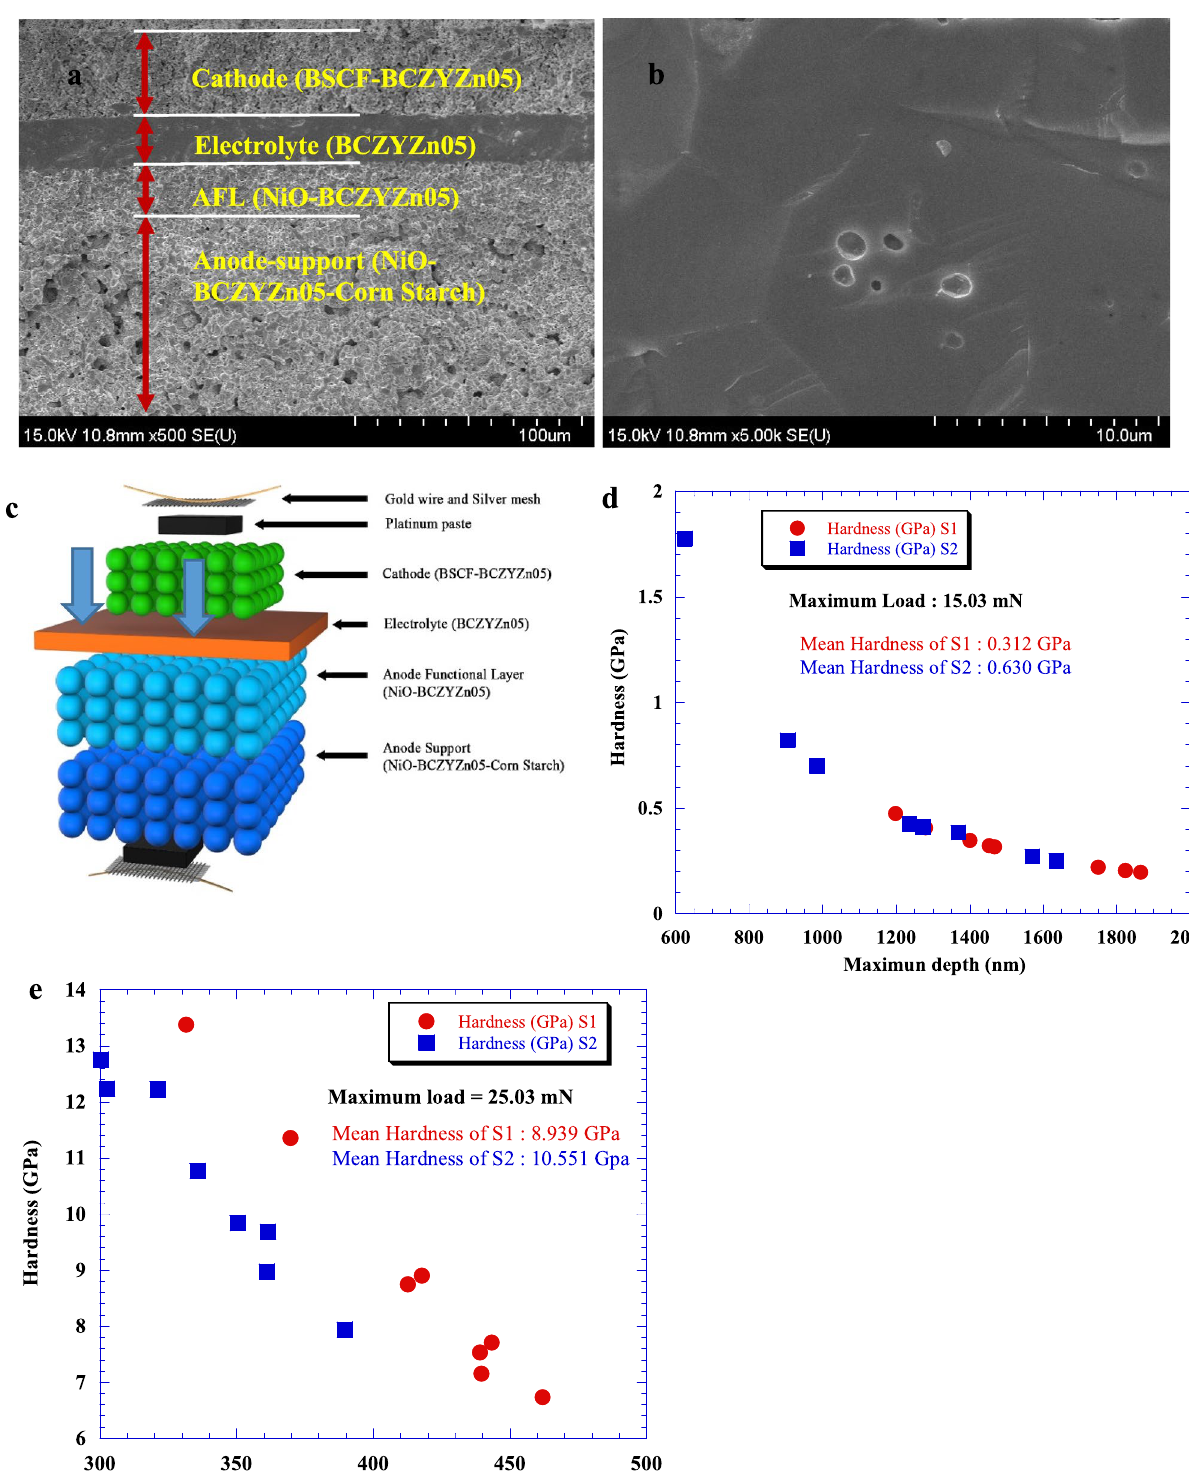
Figure 2. SEM analysis and hardness test. ( a ) Cross-sectional image of the single cell indicating the porosity difference in the anode and cathode and electrolyte. The electrolyte is the densest part of the cell and is approximately 26 μm thick. ( b ) Cross-section of the electrolyte to observe the grain size and boundaries. ( c ) Schematic diagram of nanoindentation on the cathode and electrolyte surface. Due to the higher density, the electrolyte is the hardest part of the cell. ( d ) Comparison of the hardness of the cathode between two cells without mixing BCZYZn05 with BSCF (S1) and with mixing BCZYZn05 (40%) with. BSCF (60%) (S2). ( e ) Comparison of hardness between two electrolytes: Ba 0.9 Sr 0.1 Ce 0.5 Zr 0.35 Y 0.1 Sm 0.05 O 3−δ 40 (S1) and BCZYZn05